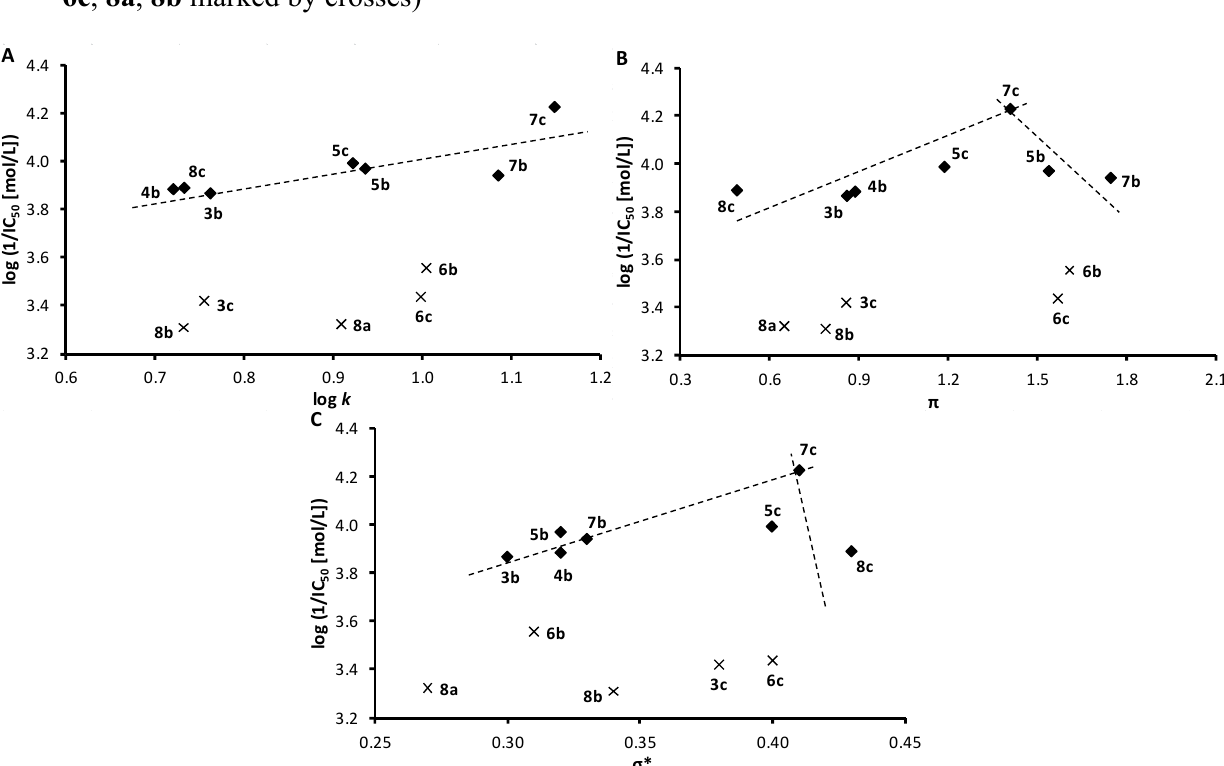
) [mol/L] in isolated spinach 50